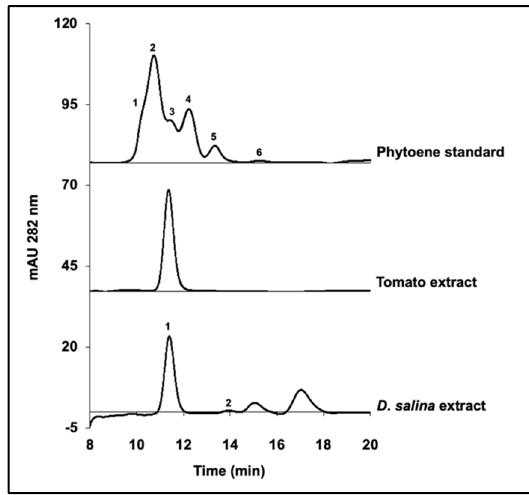
Figure 2. HPLC analysis of phytoene standard purchased from Sigma, phytoene extracts from ripe tomatoes and phytoene extracts from D. salina cultures.